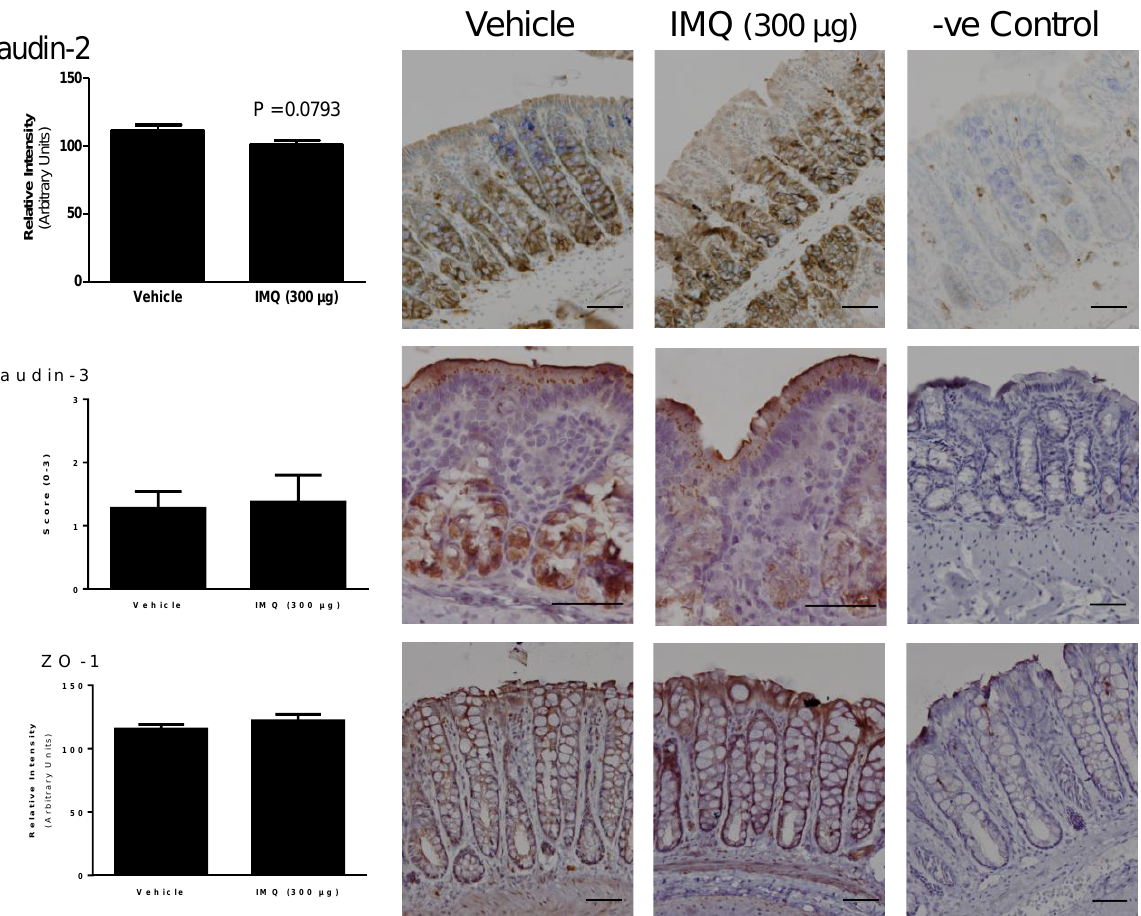
Figure 5. Immunohistochemistry for tight junction-related proteins: claudin-2, claudin-3 and ZO-1. Left column: quantification of immunostaining in control and imiquimod (IMQ)-treated rats (300 µg/rat, intracolonic). See the Materials and Methods section for details of quantification. Data are the mean ± SEM, n = 8–13 per group. Microphotographs: Representative images of a control animal (vehicle), an imiquimod (300 µg, intracolonic)-treated animal and a negative control (-ve control) for ZO-1, claudin-2 and claudin-3. Scale bar: 50 µm.